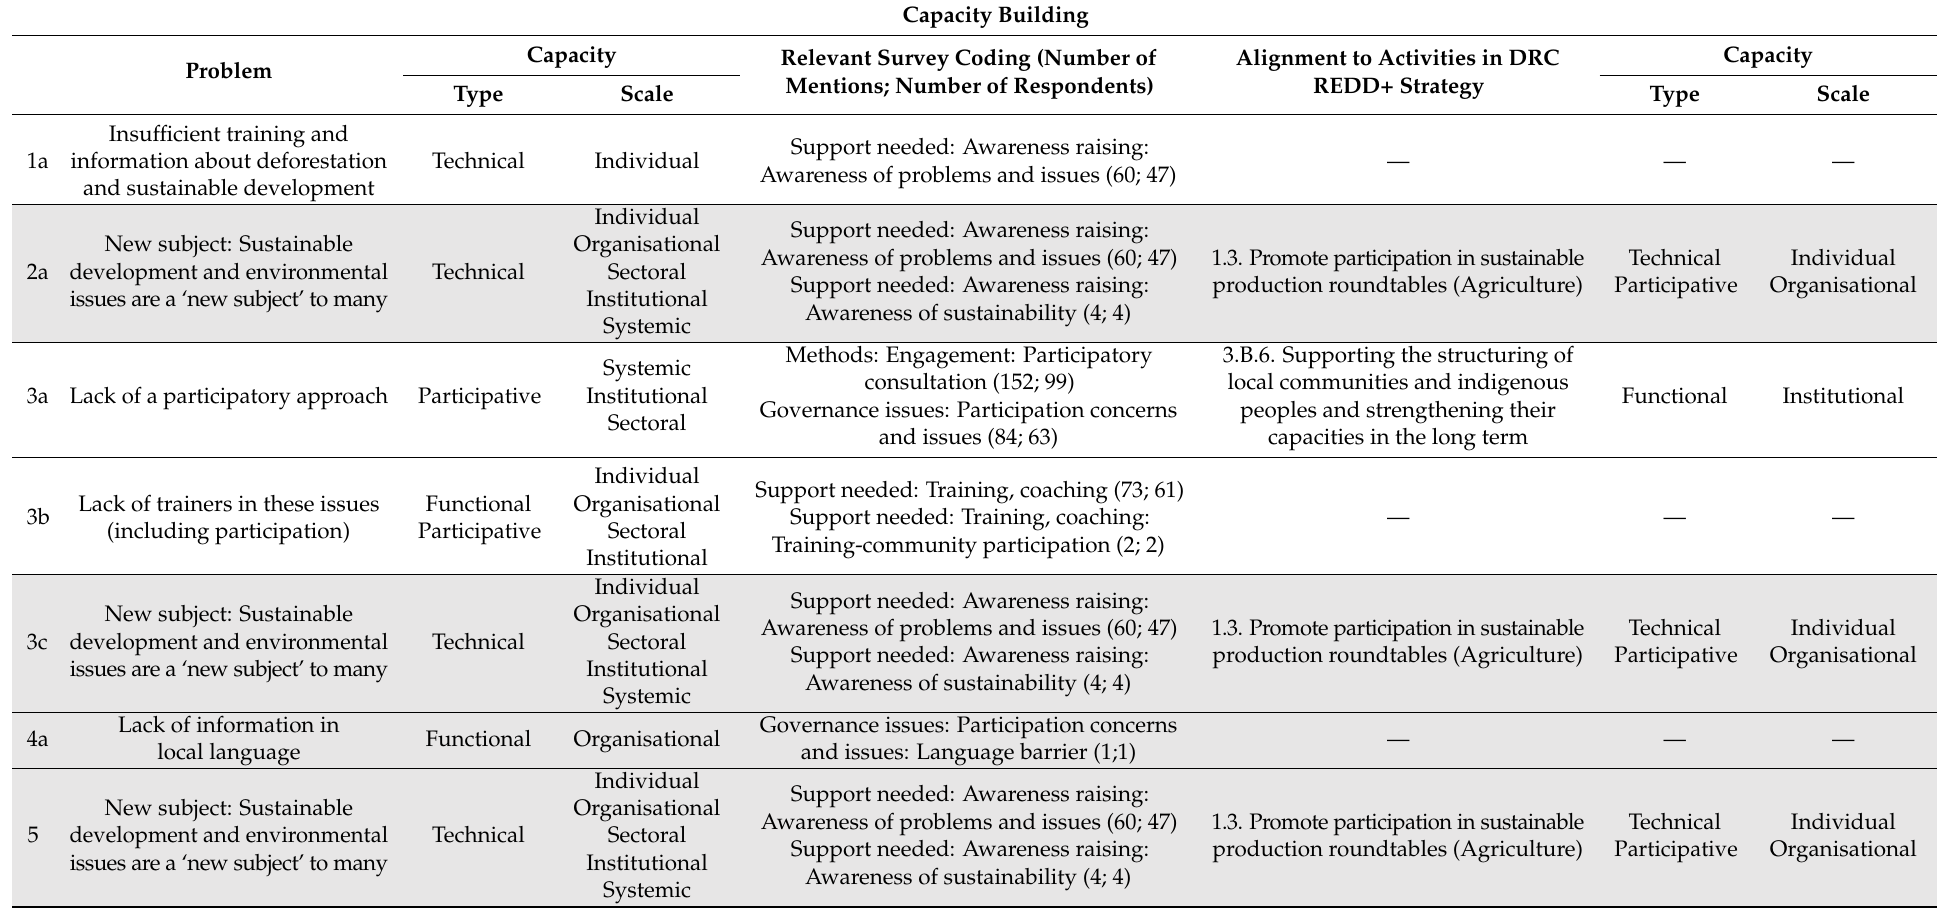
Table 3. Capacity Building Issues Identified in É quateur Provincial Government Stakeholder Workshop and Aligned DRC REDD+ Strategy Actions. Highlighted issues in grey are proximal issues from the bottom of problem tree